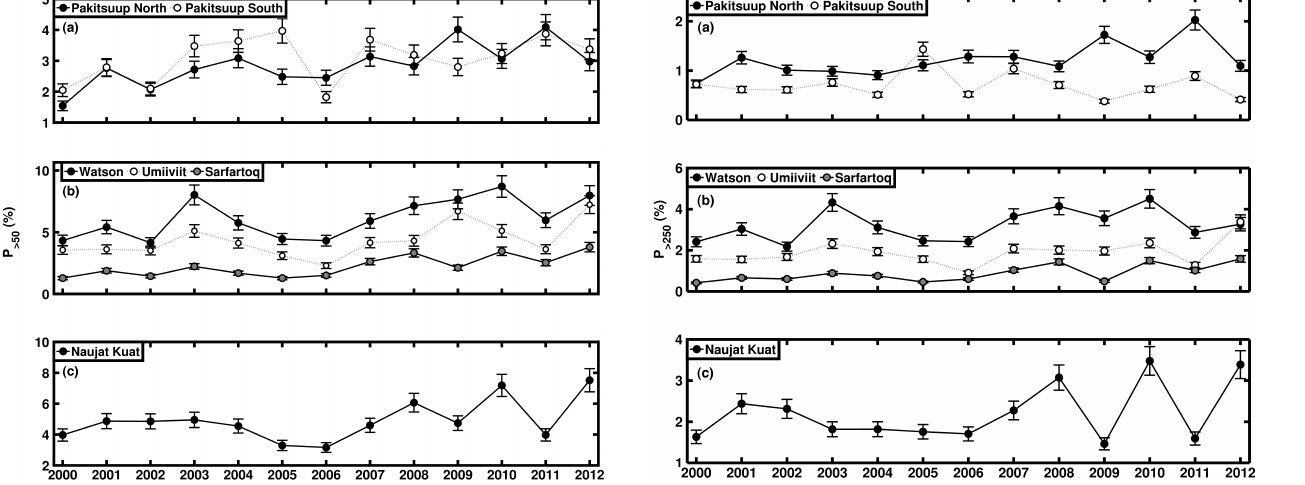
Figure 9. P > 50 for yearly melt season with error bars for (a) Pakit- suup, (b) Kangerlussuaq, and (c) Ameralik fjord plume(s).